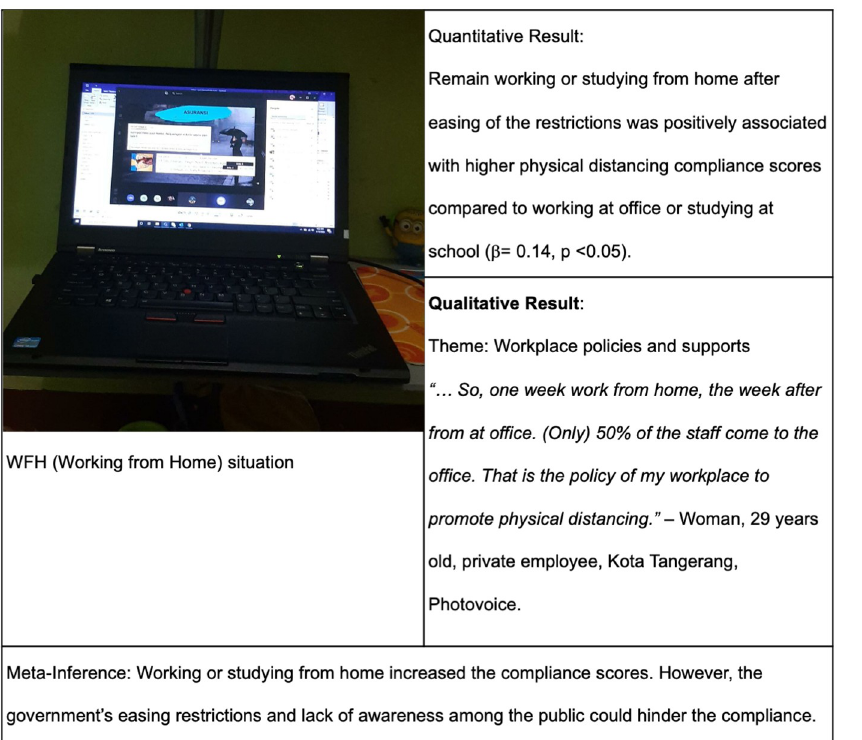
Fig 2. Joint display of workplace and government policies, awareness, and physical distancing